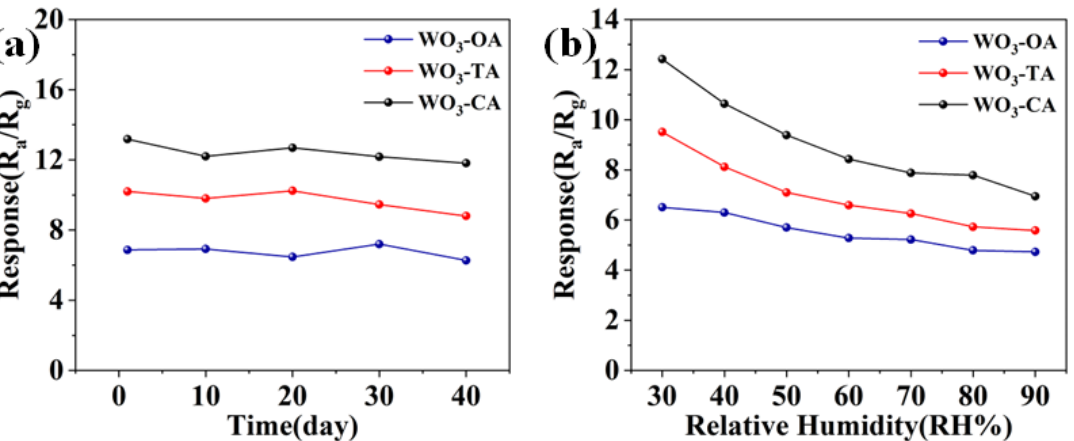
Figure 4. ( a ) Stability of the three WO 3 in 100 ppm acetone and optimal operating temperature for 40 days. ( b ) Variation of acetone gas response at different relative humidity.